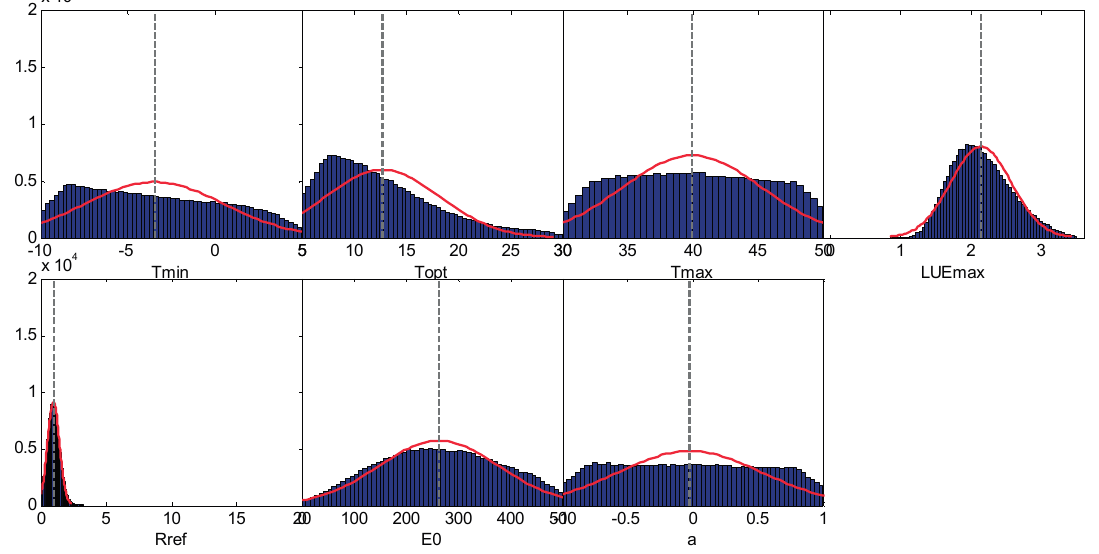
Figure 5. Histograms of the RS-CFLUX model parameters at the Zhangye wetland station